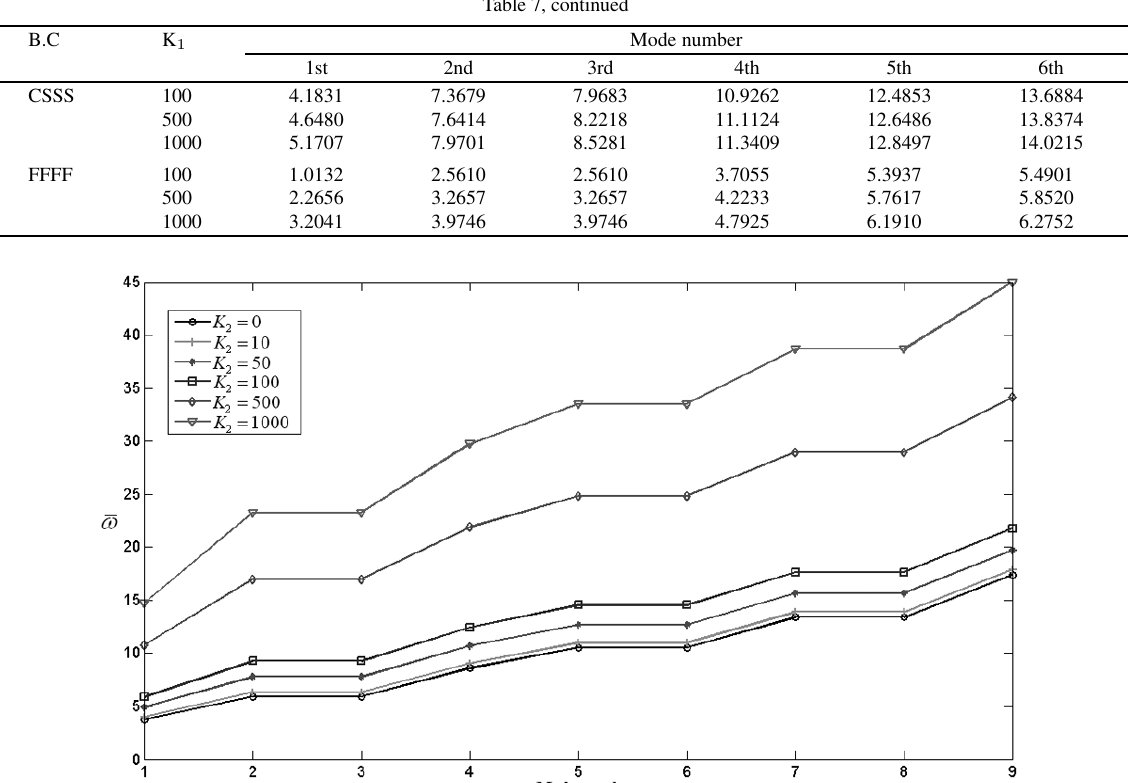
Fig. 6. Comparison of natural frequencies for Winkler and Pasternak’s type of elastic foundation ( K 1 = 1000 , h/a = 0 . 01 and number of nodes 19 ×